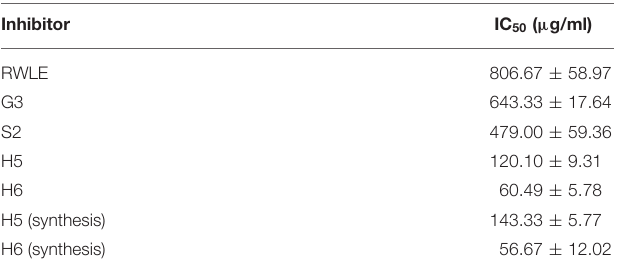
TABLE 2 | IC 50 -values of the products in each purification step.